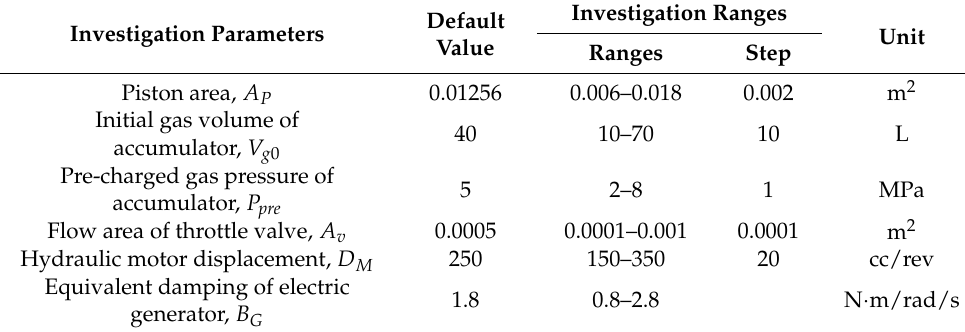
Table 4. Detailed value ranges of the case studies.